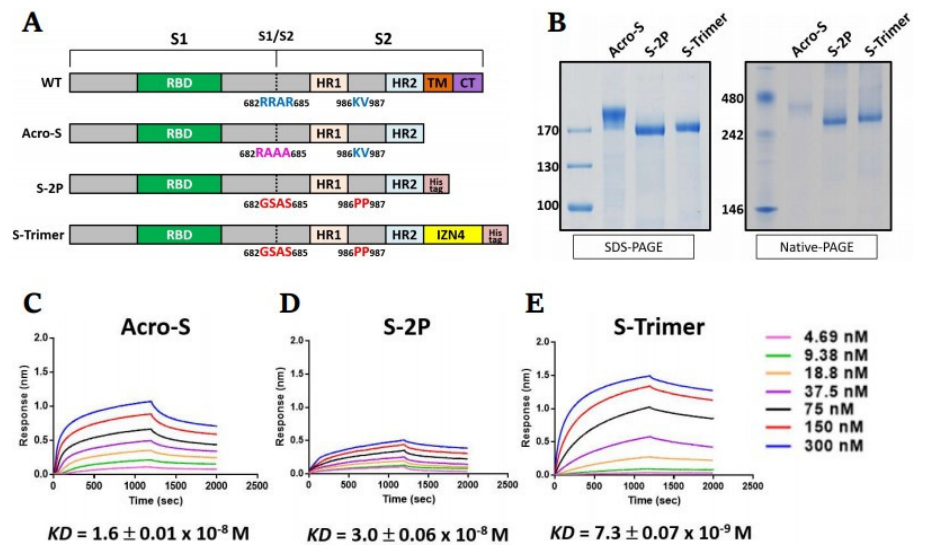
Figure 1. Design and characterization of recombinant SARS-CoV-2 spike variants. ( A ) Schematic design of SARS-CoV-2 S variants construct. Wild-type (WT) full length of SARS-CoV-2 S protein contents, RRAR residues at S1/S2, and a furin cleavage site. Acro-S has the S ectodomain without the furin cleavage site, which was substituted by “RAAA” at S1/S2. The recombinant SARS-CoV-2 S-2P protein encodes S ectodomain with a “GSAS” substitution at the furin cleavage site and two proline substitutions at residues 986 and 987 to retain in the prefusion conformation; S-Trimer was designed as S-2P fused with IZN4 trimerization domain at the C-terminal. ( B ) Reducing SDS–PAGE and native PAGE analysis of purified S-2P and S-Trimer. Molecular weight standards are indicated at the left in kDa. Kinetic profiles of ( C ) Acro-S, ( D ) S-2P, and ( E ) S-Trimer binding to human ACE2 measured by ForteBio BioLayer interferometry (BLI). The data are representative of at least three independent